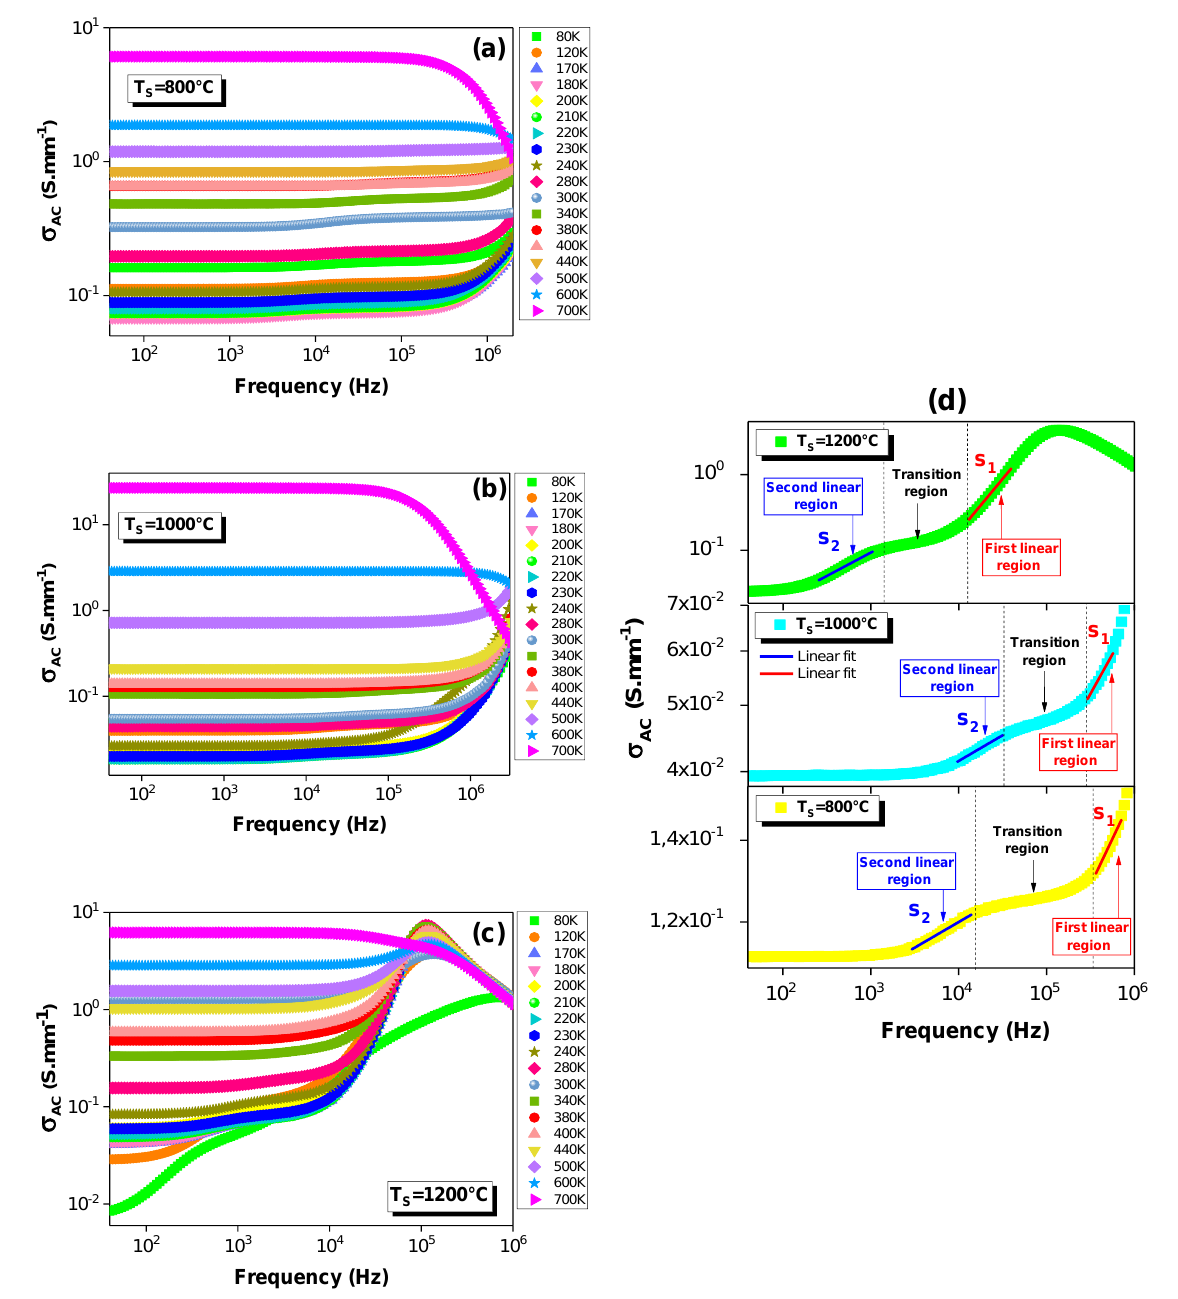
Figure 1. Frequency dependences of the electrical conductivity (σ AC ) at various temperatures for the La 0.9 Sr 0.1 MnO 3 system sintered at ( a ) 800, ( b ) 1000 and ( c ) 1200 °C. ( d ) Evolution of σ AC as a function of frequency fitted and performed at 120 K for the La 0.9 Sr 0.1 MnO 3 system sintered at different temperatures (TS).